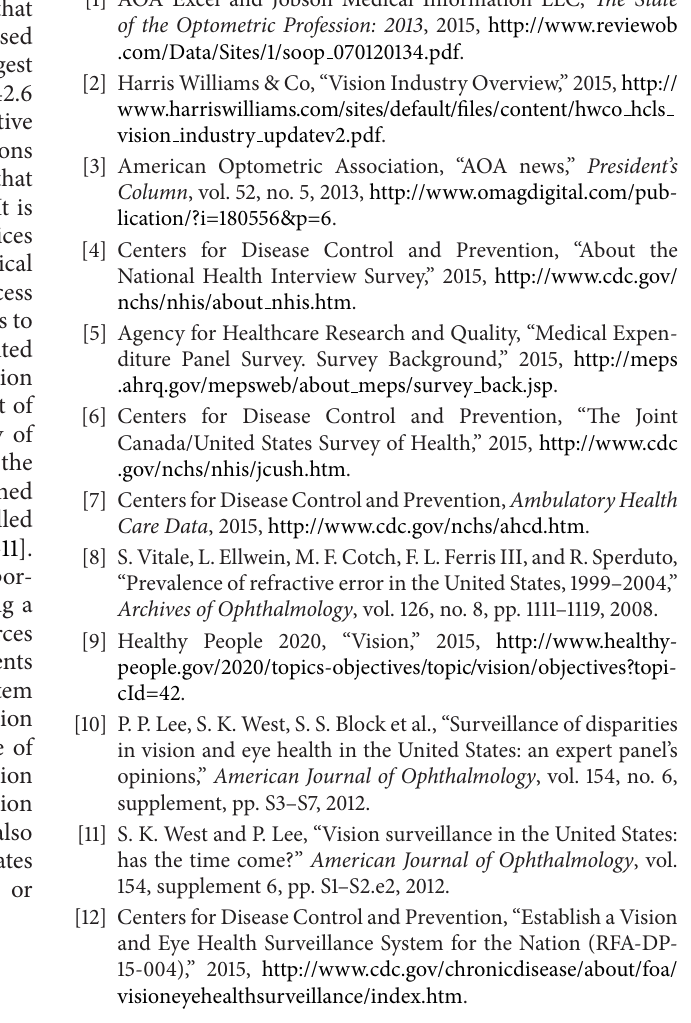
Weighted percent of adults visiting a